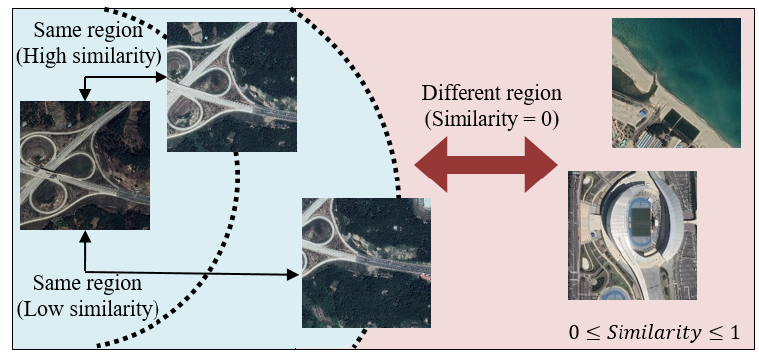
Figure 2. Illustration of the feature embedding concept. First, the regions between images are distinguished in a binary manner, which denotes the same region or not. Then, the degree of similarity is defined as a label, which indicates how the contents of the images overlap each other. The distance of the features is rearranged according to the